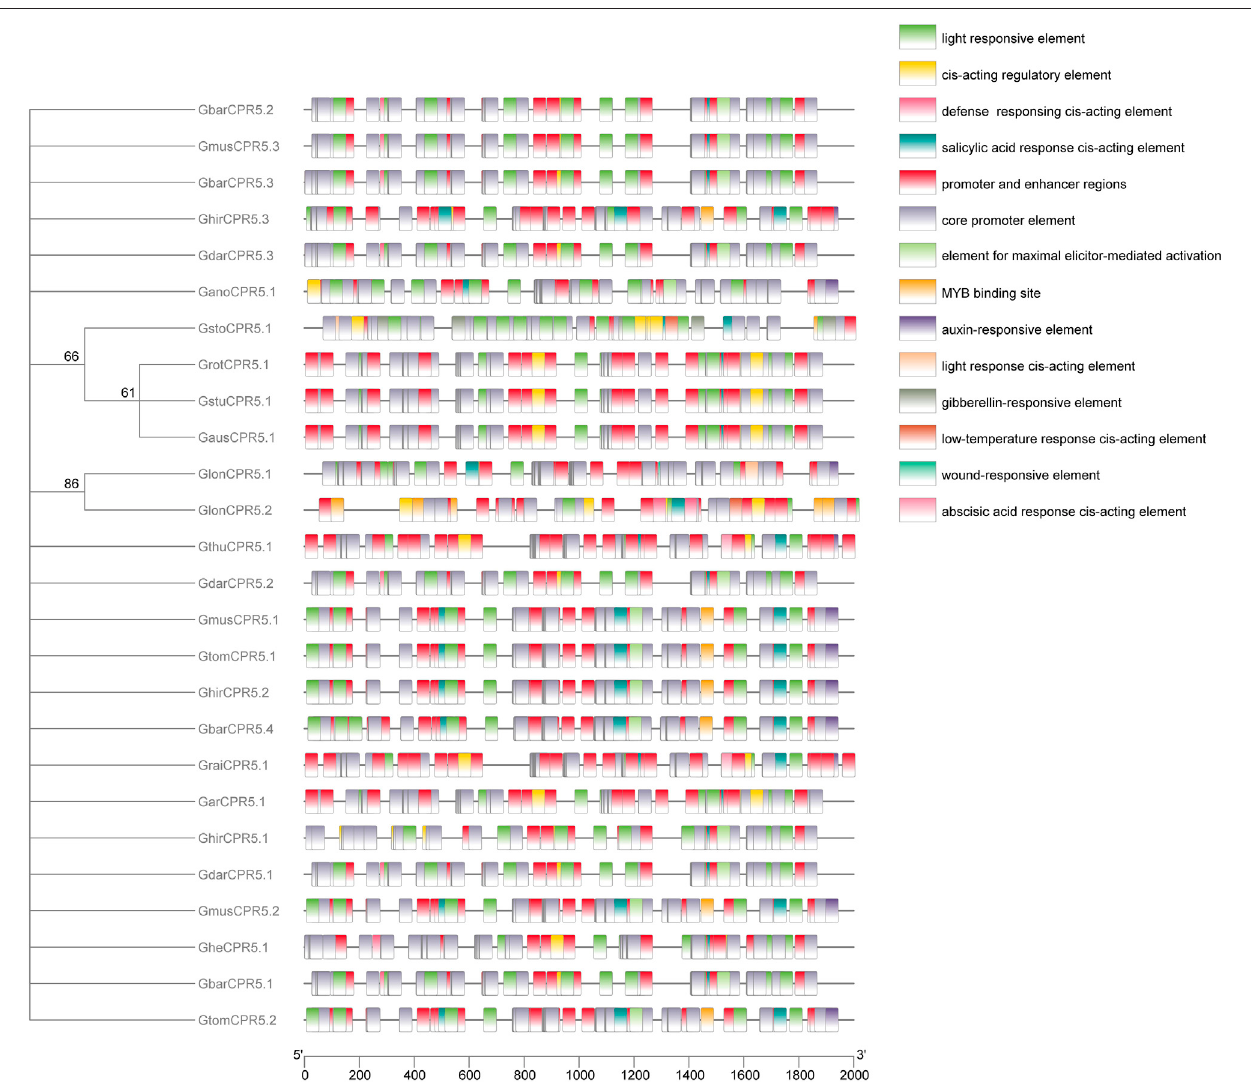
FIGURE5| Predictedcis-elementsin CPR5 promoters.Promotersequences(2,000bpupstreamregions)of18 CPR5 geneswereexaminedonlineatPlantCARE web server. Diverse colors were used for representing different cis-elements, as given in on the right side.